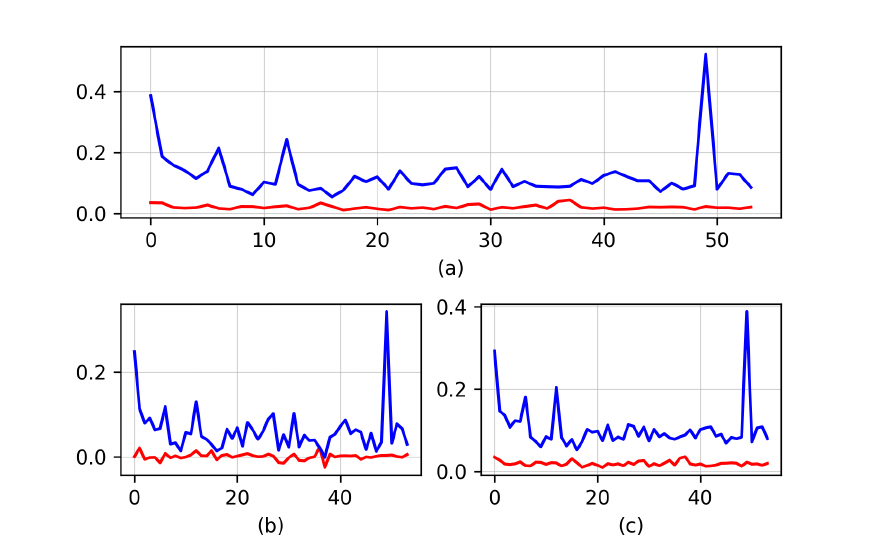
Figure 7. Comparison between the raw point cloud (blue) and the clean one (red) against the LiDAR-based mesh. ( a ) Root Mean Square Error (RMSE), ( b ) Mean Distance, and ( c ) Standard Deviation, all measurements in cm. The x axis represents the volunteer